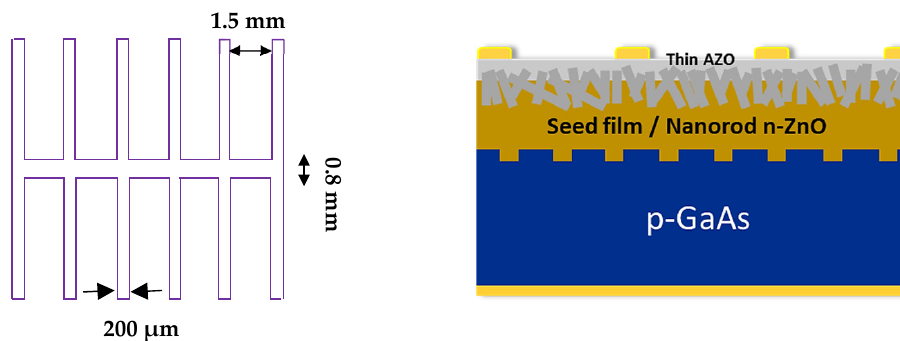
Figure 2. Schematic illustration of the proposed heterojunction design in its final optimized structure ( right ) and the front contact dimensions ( left ), achieved after a four-step process, detailed in this work.